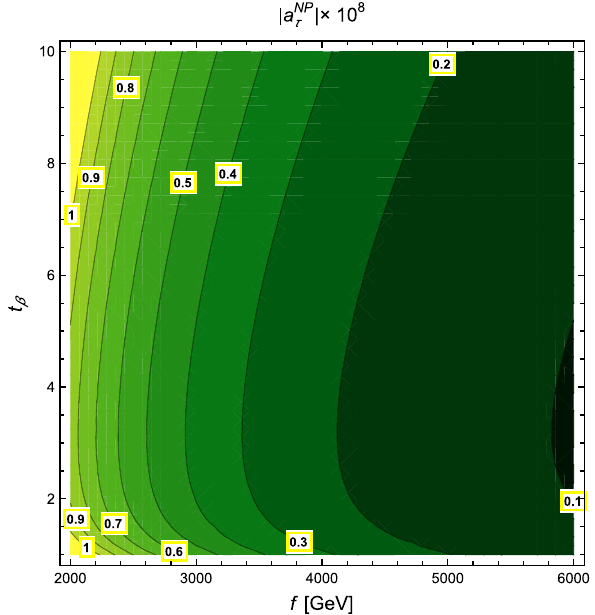
Fig. 7 Contours of the SLHM contribution to | a NP τ | in the f vs. t β plane. For the remaining parameters of the model we use the values shown in Table